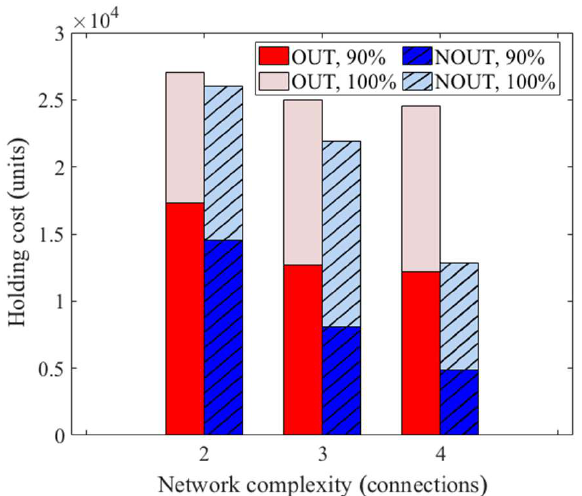
Figure 12. Relation of holding cost with respect to the network complexity in terms of the policy used and the customer satisfaction.